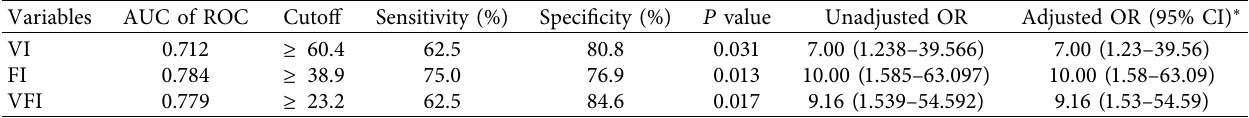
Table 5: ROC curve of vascularity indexes on massive blood